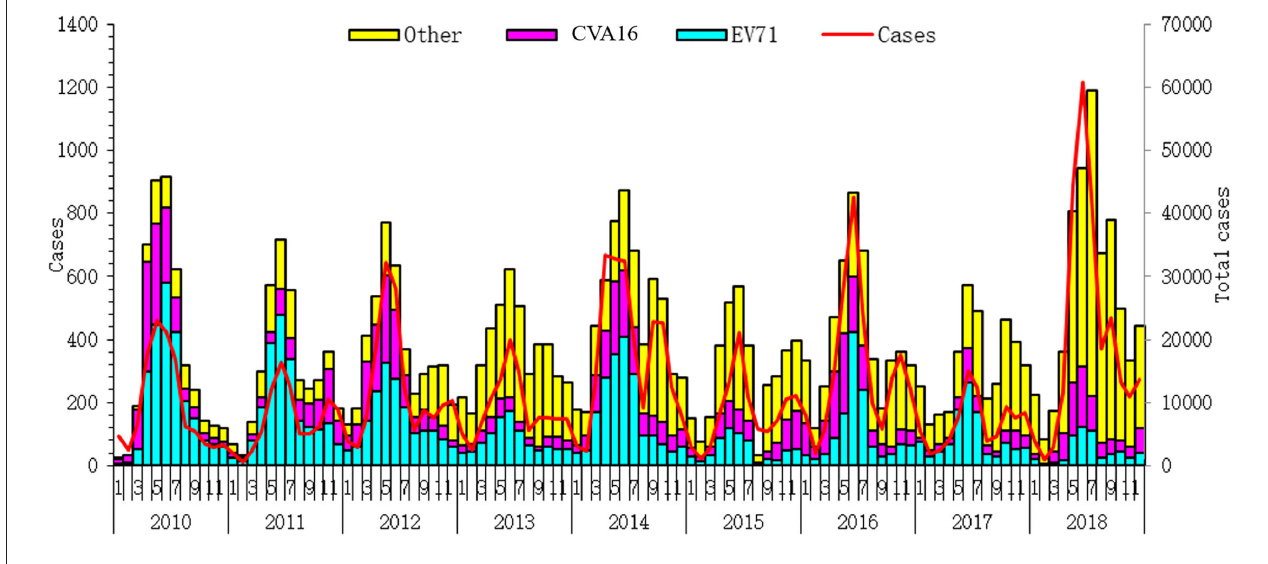
FIGURE 2 | Total number of hand-foot-mouth disease (HFMD) cases and serotype-specific cases from 2010 to 2018 in Zhejiang province.